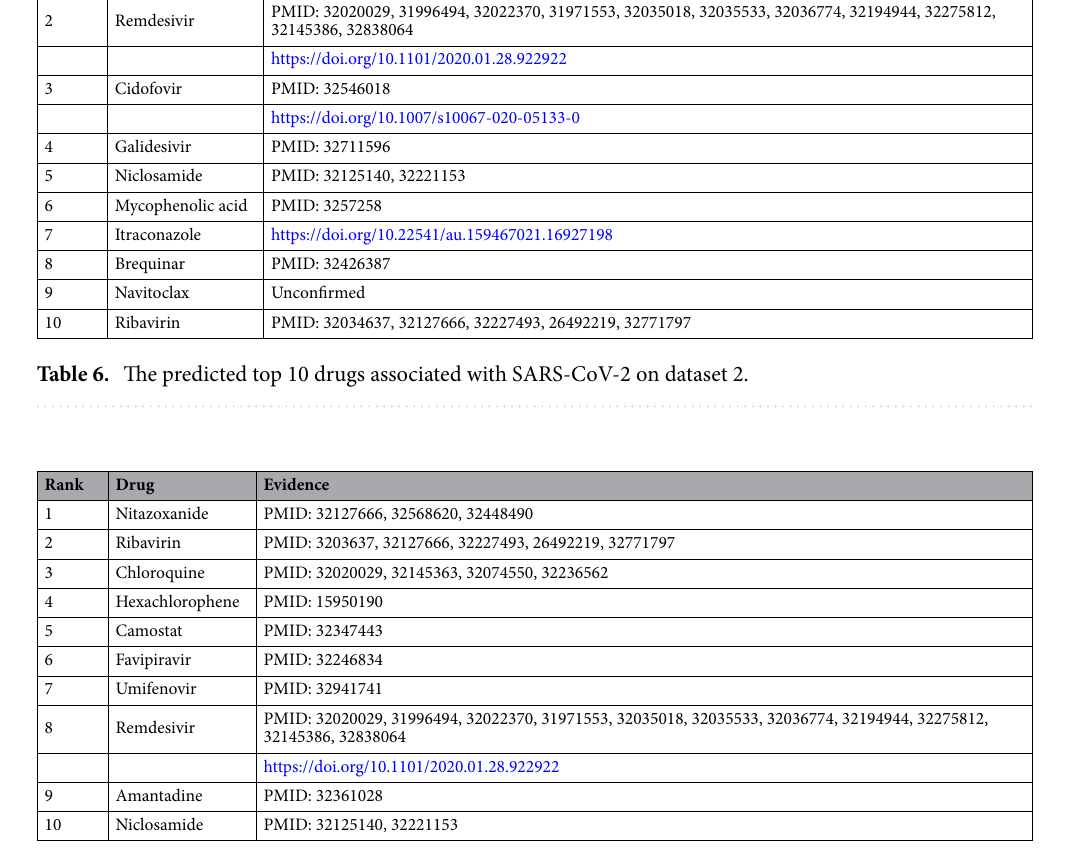
Table 7. The predicted top 10 drugs associated with SARS-CoV-2 on dataset 3.